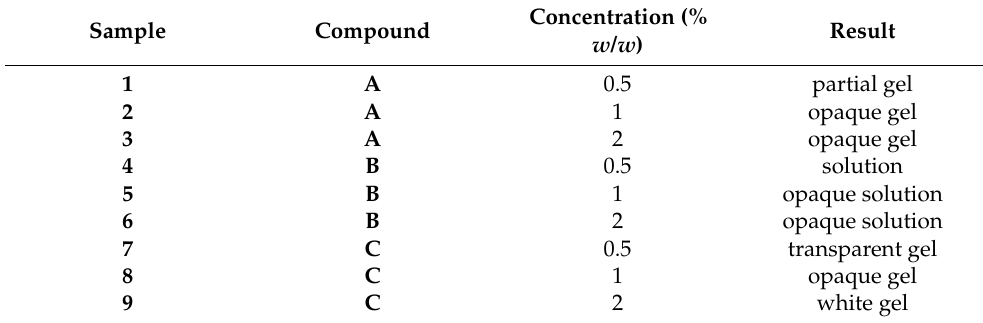
Table 1. Results for the formation of hydrogels from A , B and C , using the pH change method.